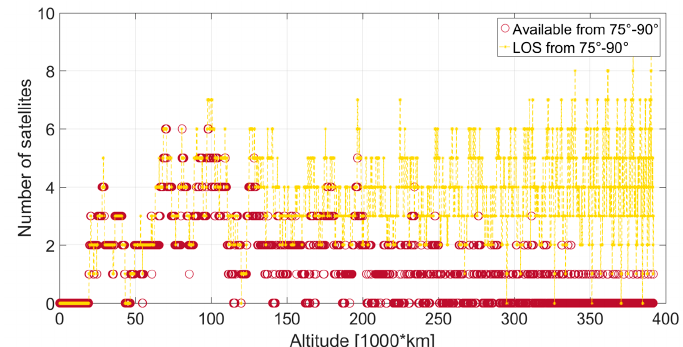
Figure 41. Visible satellites (in the line of sight (LOS)) and available satellites at the receiver’s position, for which the corresponding signal is transmitted at an angle between 62° and 75° from the transmitter’s boresight.